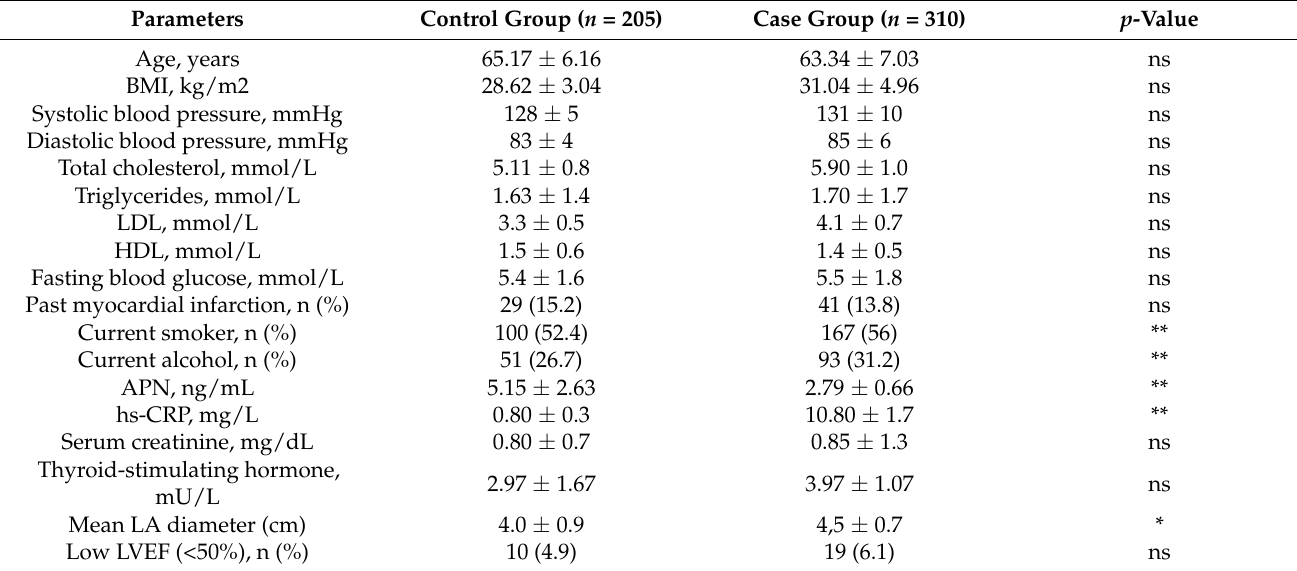
Figure 1. Flow chart of the study population. Table 1. Baseline characteristics of study